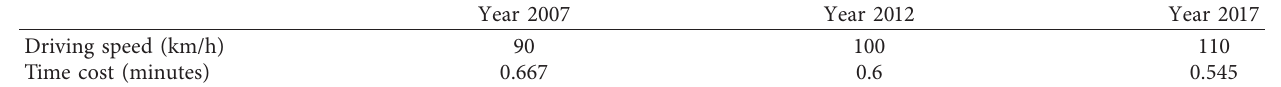
Table 1: Speed and time cost of highway transportation in different periods.